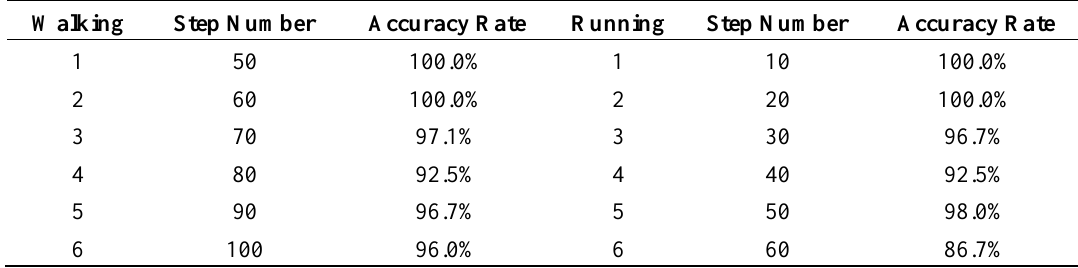
Table 2. Gait recognition based on the ZDET